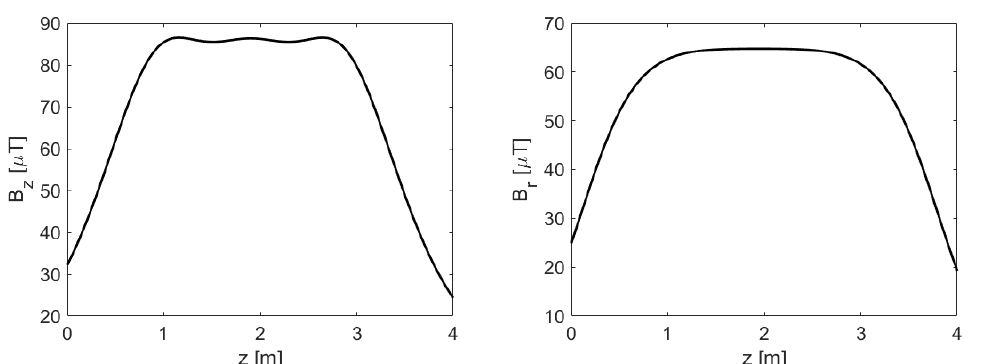
Figure 3. The axial ( left ) and radial ( right ) component of the magnetic field on the axis. The current is assumed to be